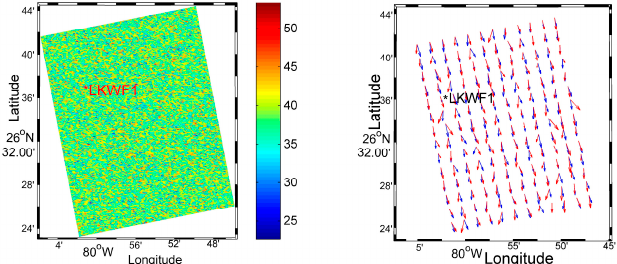
Figure 7. RADARSAT-2 SAR image in the North Atlantic, off Florida, at 02:12:56 on 19 January 2013, collocated with NDBC buoy LKWF1 showing: ( a ) VH polarization; ( b ) VV polarization; ( c ) SAR- Figure 8. Retrieved-ocean current ( left ) and directions ( right , blue vectors are retrieved-ocean derived wind fields; and ( d ) DWF wind fields. directions and red vectors are measured by HF radar) distribution map. Units are centimeters per second, and degrees, respectively. The ocean current speed is 46.5 cm/s and the corresponding current direction is 177.2° at buoy #LKWF1. Table 2. Winds retrieved from fully polarimetric SAR images and NDBC buoy ##LKWF1, ocean surface currents measured by HF radar and retrieved ocean currents. Parameters of four kinds of data are simultaneous and collocated. Data are received on 19 January 2013.